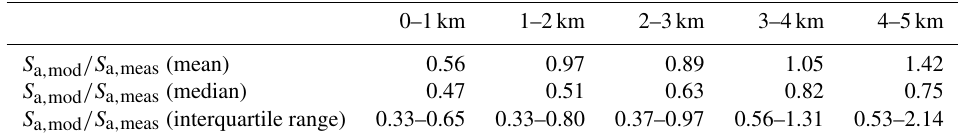
Figure 8. Ratio of modeled to measured aerosol surface area concentration ( S a , mod /S a , meas ) including median (red line within blue box), and interquartile ranges (blue box with the 25th percentile at the left end and 75th percentile at the right end) in 1km altitude bins. The red crosses outside of the bounds of the plot denote outliers. The labels on the altitude axis lie at the midpoint of the 1km altitude bin. Table 2. Mean, median, and interquartile range (range of 25th to 75th percentile) surface area ratio ( S a , mod /S a , meas ) for each 1km altitude bin from 0–5km.